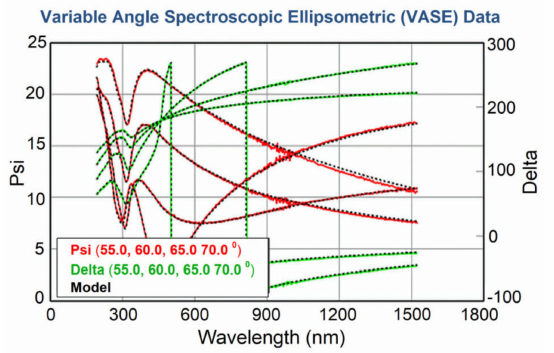
Figure 7. Ellipsometric angles Psi (red) and Delta (green) together with fitted model (dashed line) for WO 3 thin films measured for di ff erent incident angles (55 ◦ –70 ◦ ).